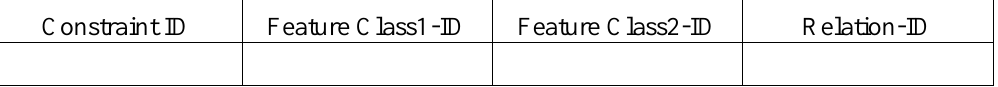
Figure 4. Structure of the table designed for storing defined constraints elements. Constraint ID Feature Class1-ID Feature Class2-ID